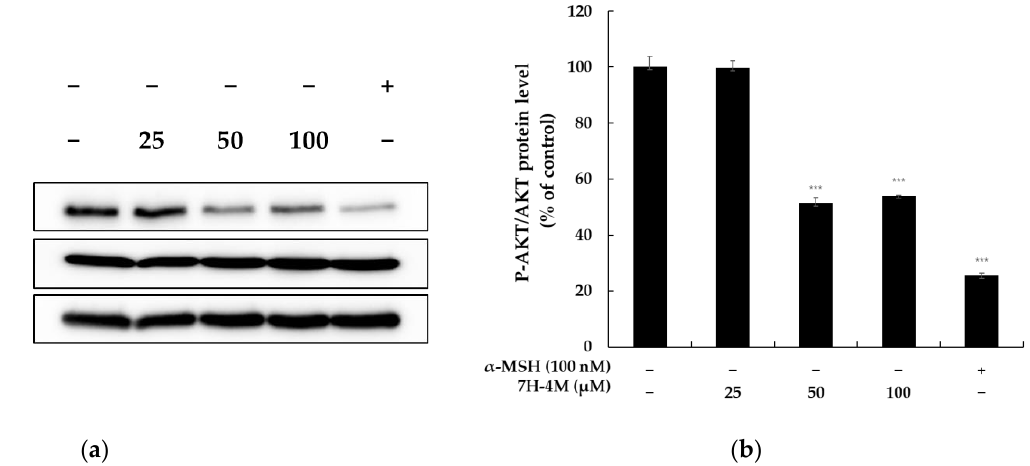
Figure 6. The effect of 7H-4M on the melanogenesis-related protein expression of B16-F10 cells. The cells were treated with 7H-4M at the indicated concentrations for 24 h and were then harvested. Protein extracts were prepared from each treatment group to evaluate the expression of P-AKT. The relative intensity of the protein band was quantified using ImageJ software, and the value was normalized to that of the corresponding loading control. The untreated cells were considered as 100%. ( a ) Western blotting results and ( b ) P-AKT protein expression. The values are presented as the mean ± SD of at least three independent experiments. Statistical analysis was performed using *** p < 0.001 compared to the control group.